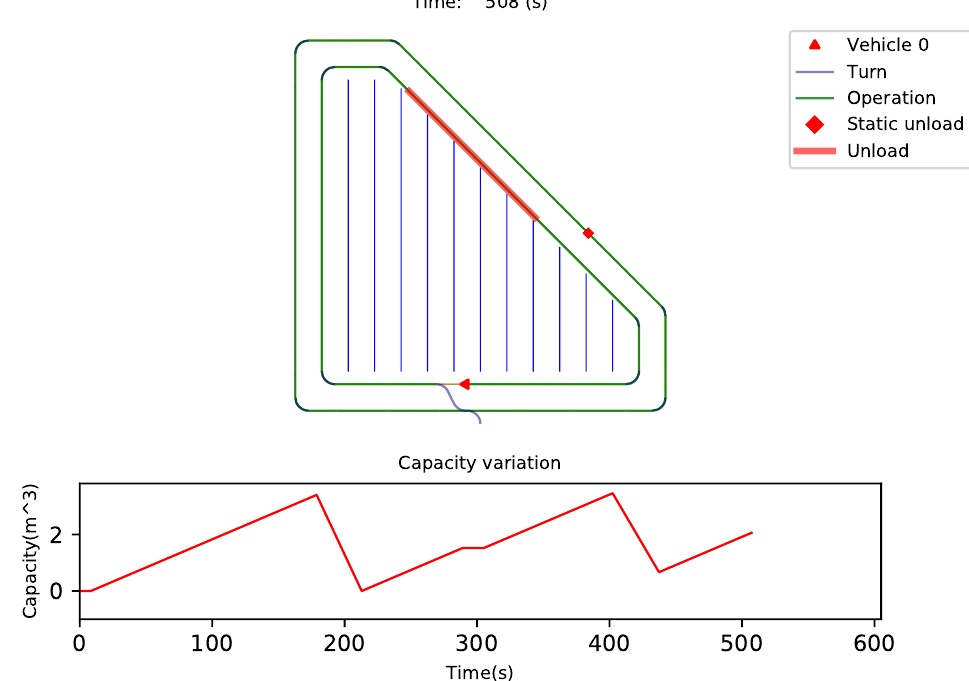
Figure 6. Headland route example with stationary and on-the-go unloading for a simplified field shape. A stationary unload is performed in the outermost headland track. An on-the-go unloading is performed in the second headland track. A clockwise driving direction is set for both headland paths. The bin level of the PU is illustrated in the diagram below the route example. Time zero is where